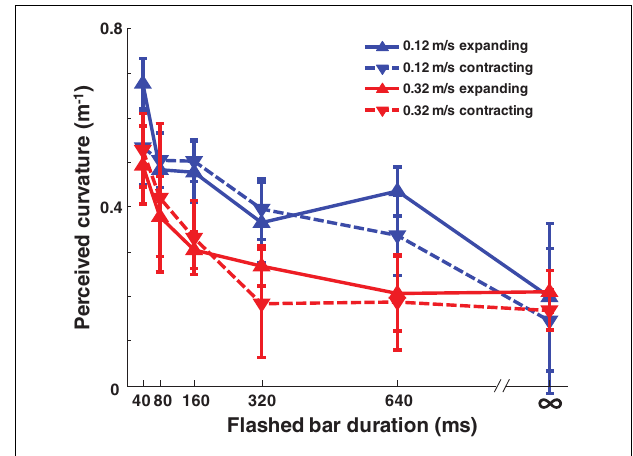
FIGURE 3 | The magnitude of the Hering illusion decreases with increasing bar duration and dot speed, both of which give evidence that the bars should not be expected to move with the background. Accordingly, the warping of the bars diminishes. n = 9, error bars